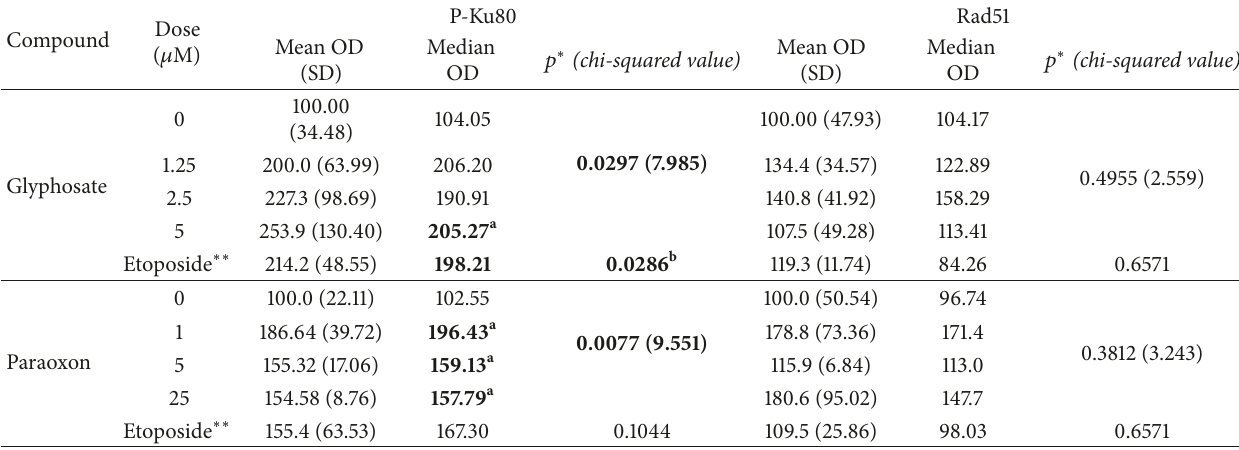
Table 4: Detection of Ku80 phosphorylated and Rad51 proteins in mononuclear cells treated with pesticides and metabolites that induced 𝛾 -H2AX